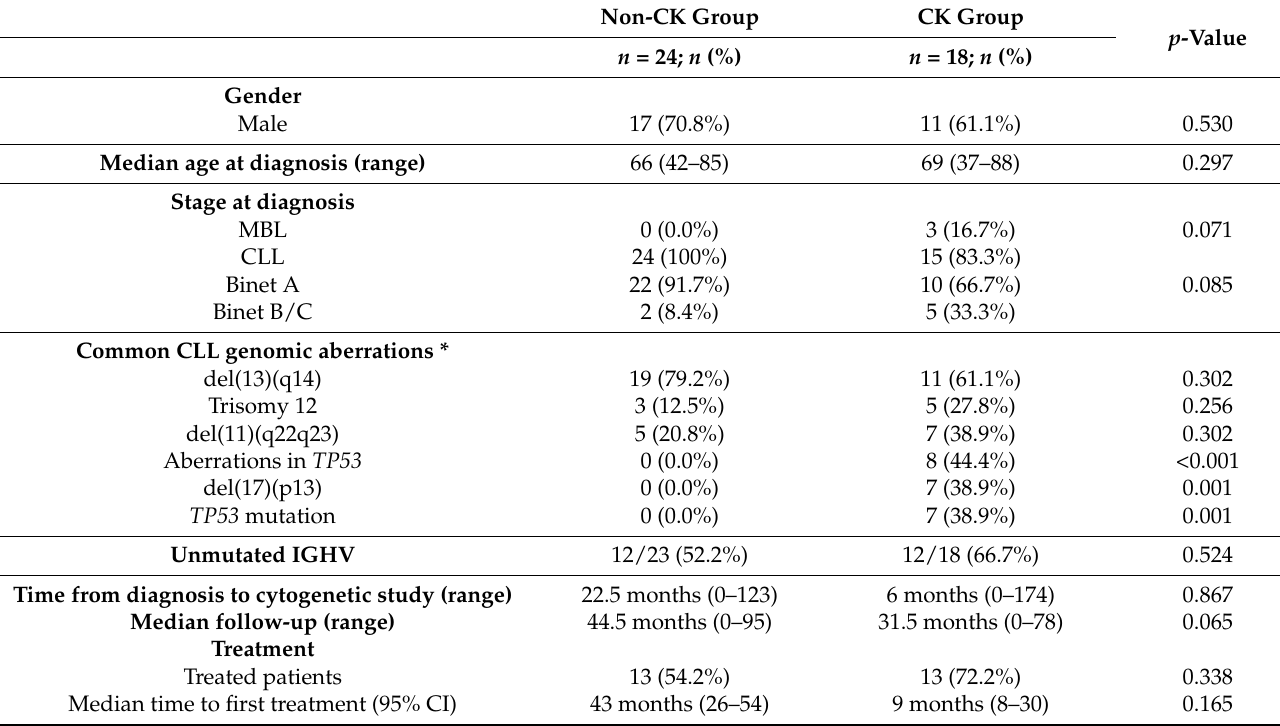
Table 1. Baseline characteristics of patients at diagnosis and last